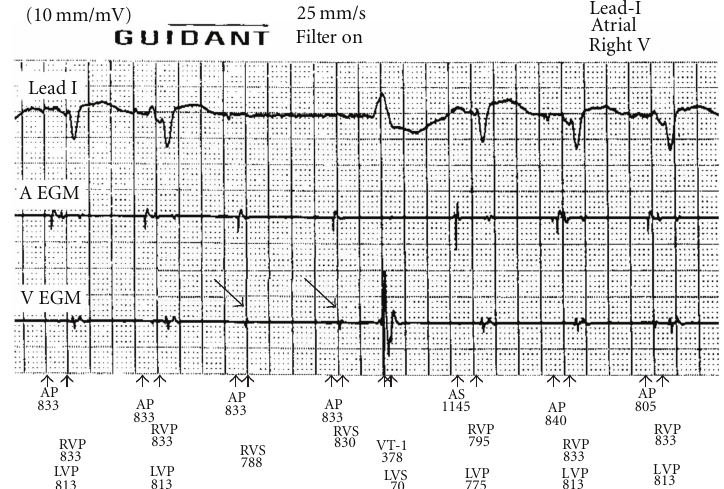
Figure 1: Pacing at DDD 65/110 beats per minute. Shown from top to bottom are the lead I, atrial electrogram (A egm), right ventricular electrogram (V egm), and annotations. AP: atrial pacing; AS: atrial sensing; RVP: right ventricular pacing; RVS: right ventricular sensing; LVP: left ventricular pacing. Cross-talk inhibition occurs at the fourth and fifth complex (arrows).